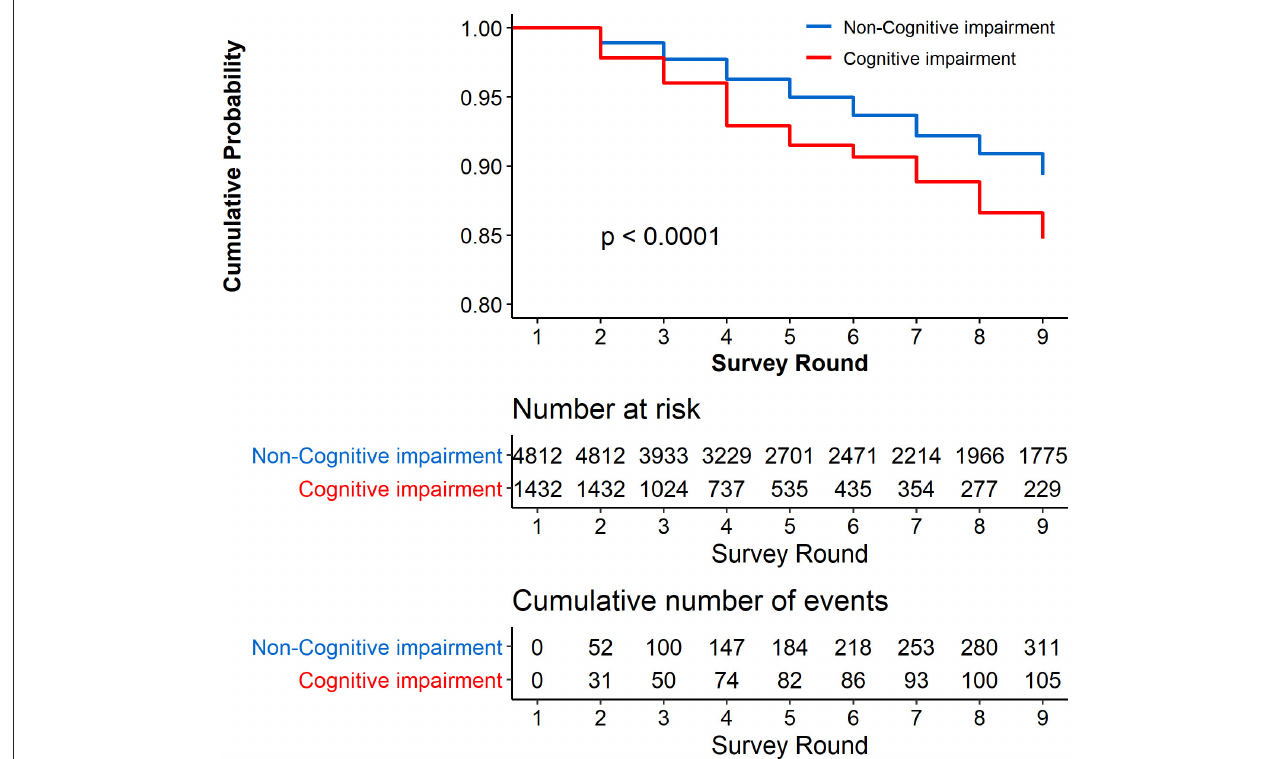
FIGURE 3 | Cumulative Probability of not reporting stroke during the 8 years of follow-up. Respondents with stroke at the baseline were excluded ( N =